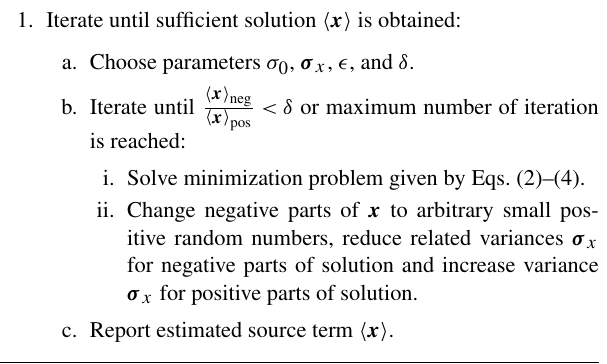
Algorithm 1 The main ideas of algorithm from